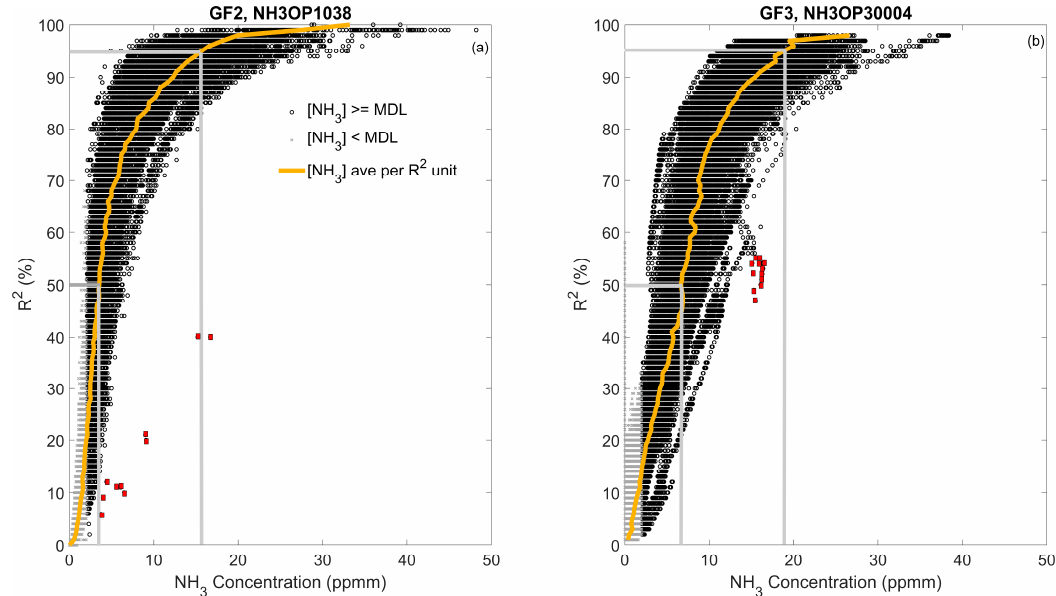
Figure 3. Raw NH 3 concentration (ppmm) versus R 2 (%) from GasFinder2 NH3-OP1038 ( a ) and GasFinder3 NH3-OP30004 ( b ) during measurements at the composting facility. The path lengths were 58 m. Yellow lines indicate the averaged ppmm value for each R 2 interval. Gray droplines show R 2 = 50 and 95%. Each point represents 1–2 seconds. Symbols indicate data that were filtered out below the minimum detection limit (MDL) (×) and manually removed ( ■ ).